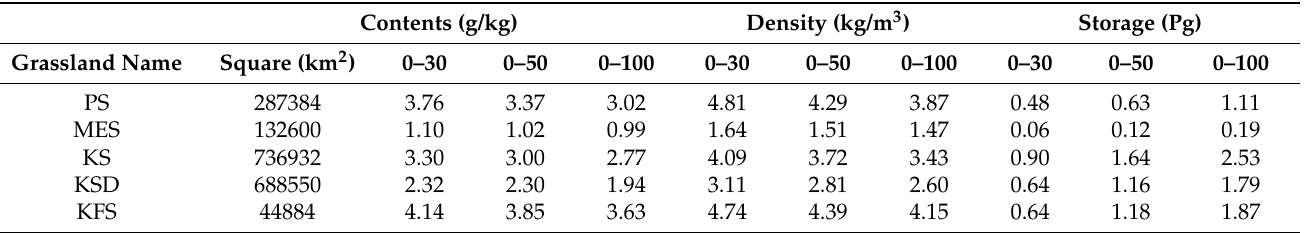
Table 2. Nitrogen content, nitrogen density, and nitrogen storage in different soil layers (0–30, 0–50, and 0–100 cm) in a typical Central Asian